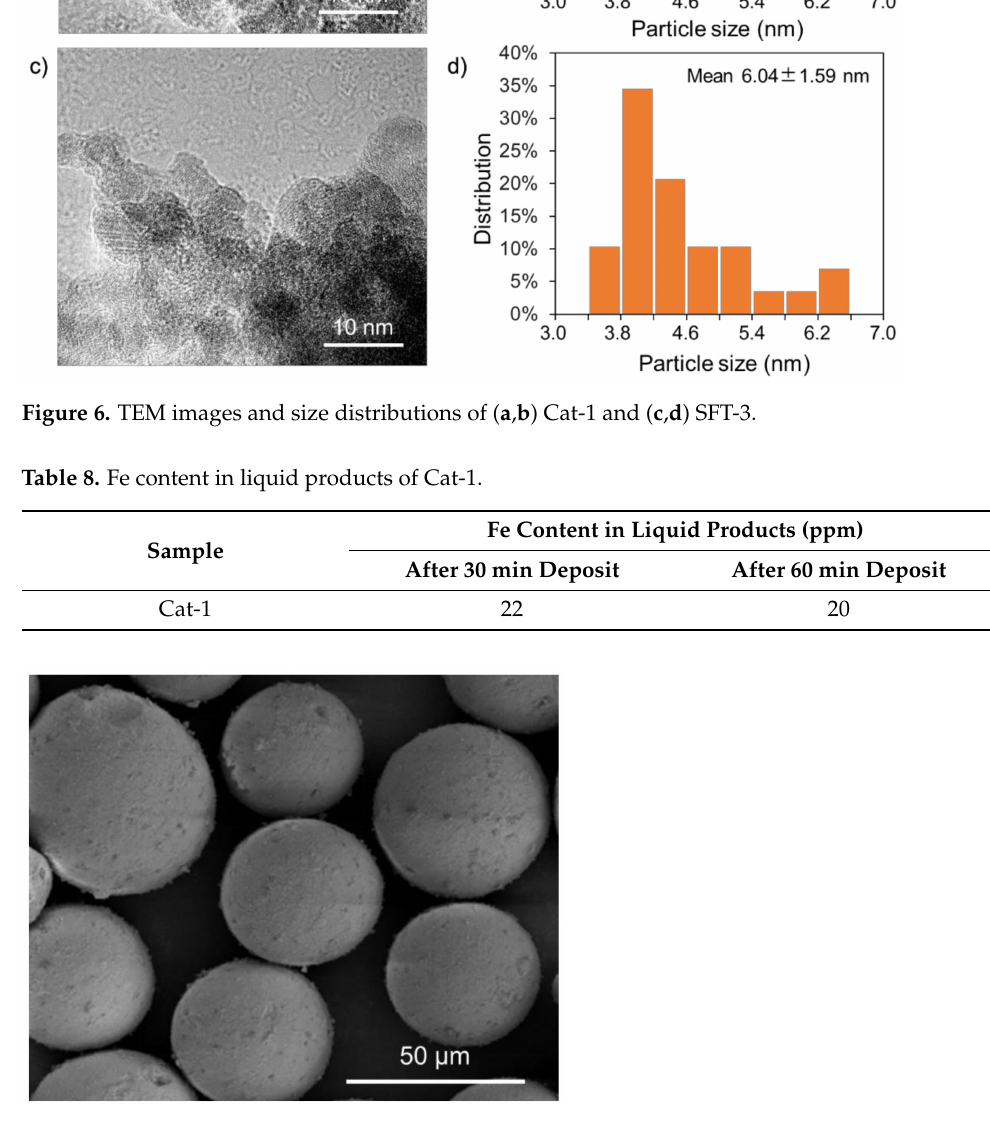
Figure 7. SEM image of Cat-1 after attrition test in slurry bed